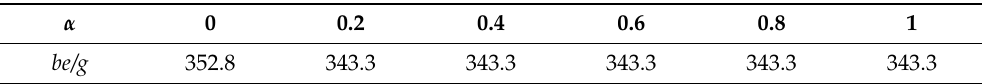
Table 11. Average specific fuel consumption corresponding to the compensable coefficient of different motors under working condition A in the bench test.